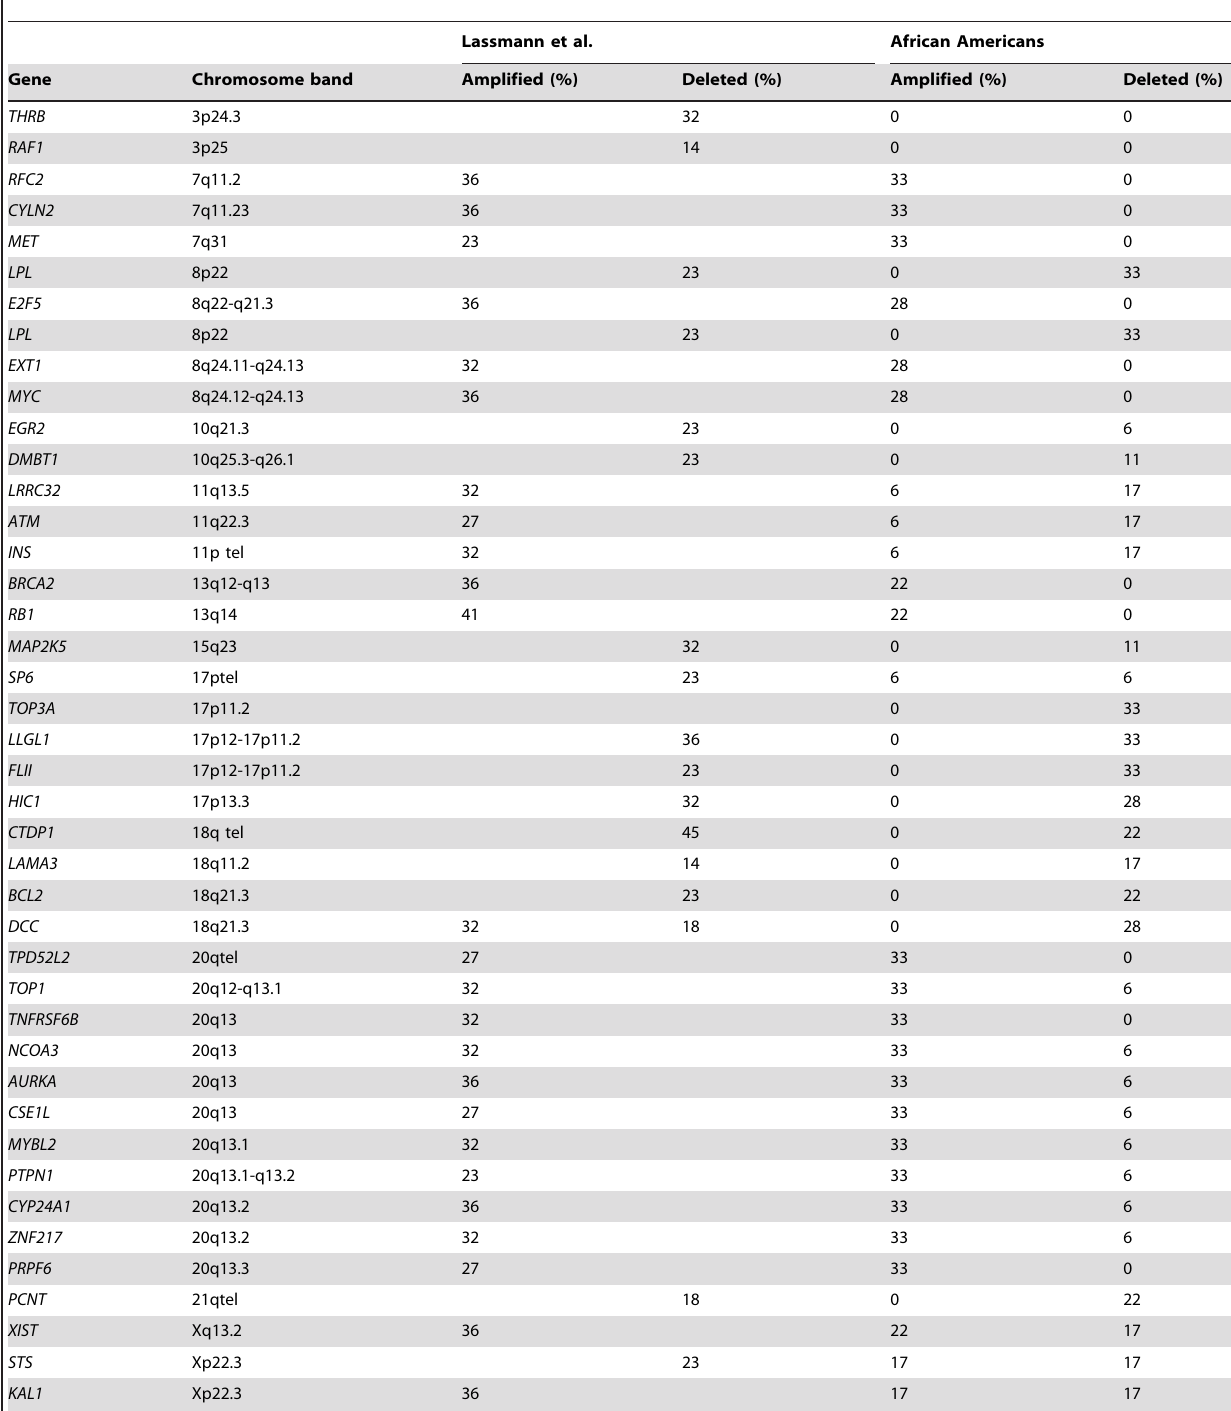
Table 4. Distribution of TSG and oncogenes aberrations in African Americans and Caucasians reported by Lassmann et al (22).